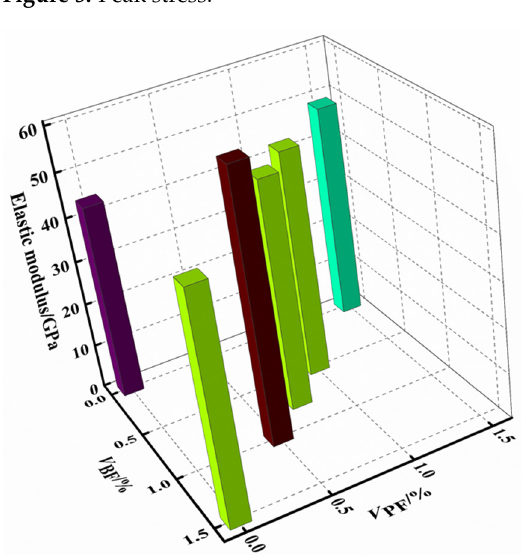
Figure 5. Peak stress.